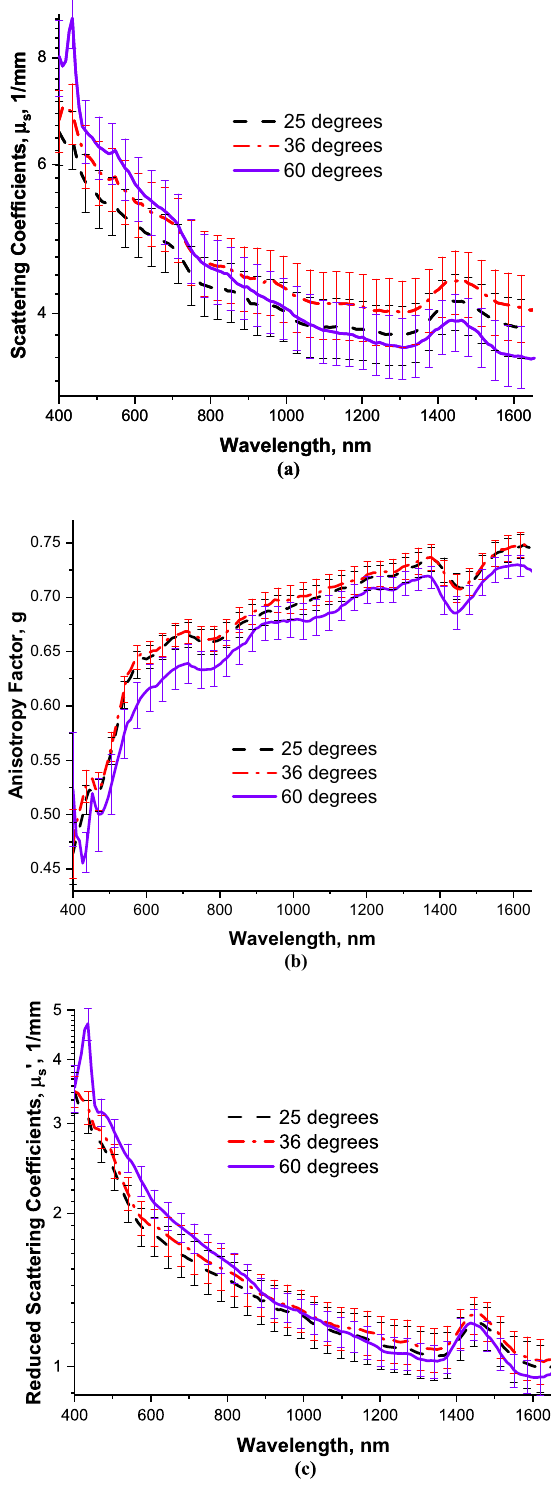
Figure 2. ( a ) Scattering coefficients between 400–1650 nm. ( b ) Anisotropy factors between 400–1650 nm. ( c ) Reduced scattering coefficients between 400–1650 nm. Dashes—25 °C. Dashes and dots—36 °C. Solid line— 60 °C. Bars—standard